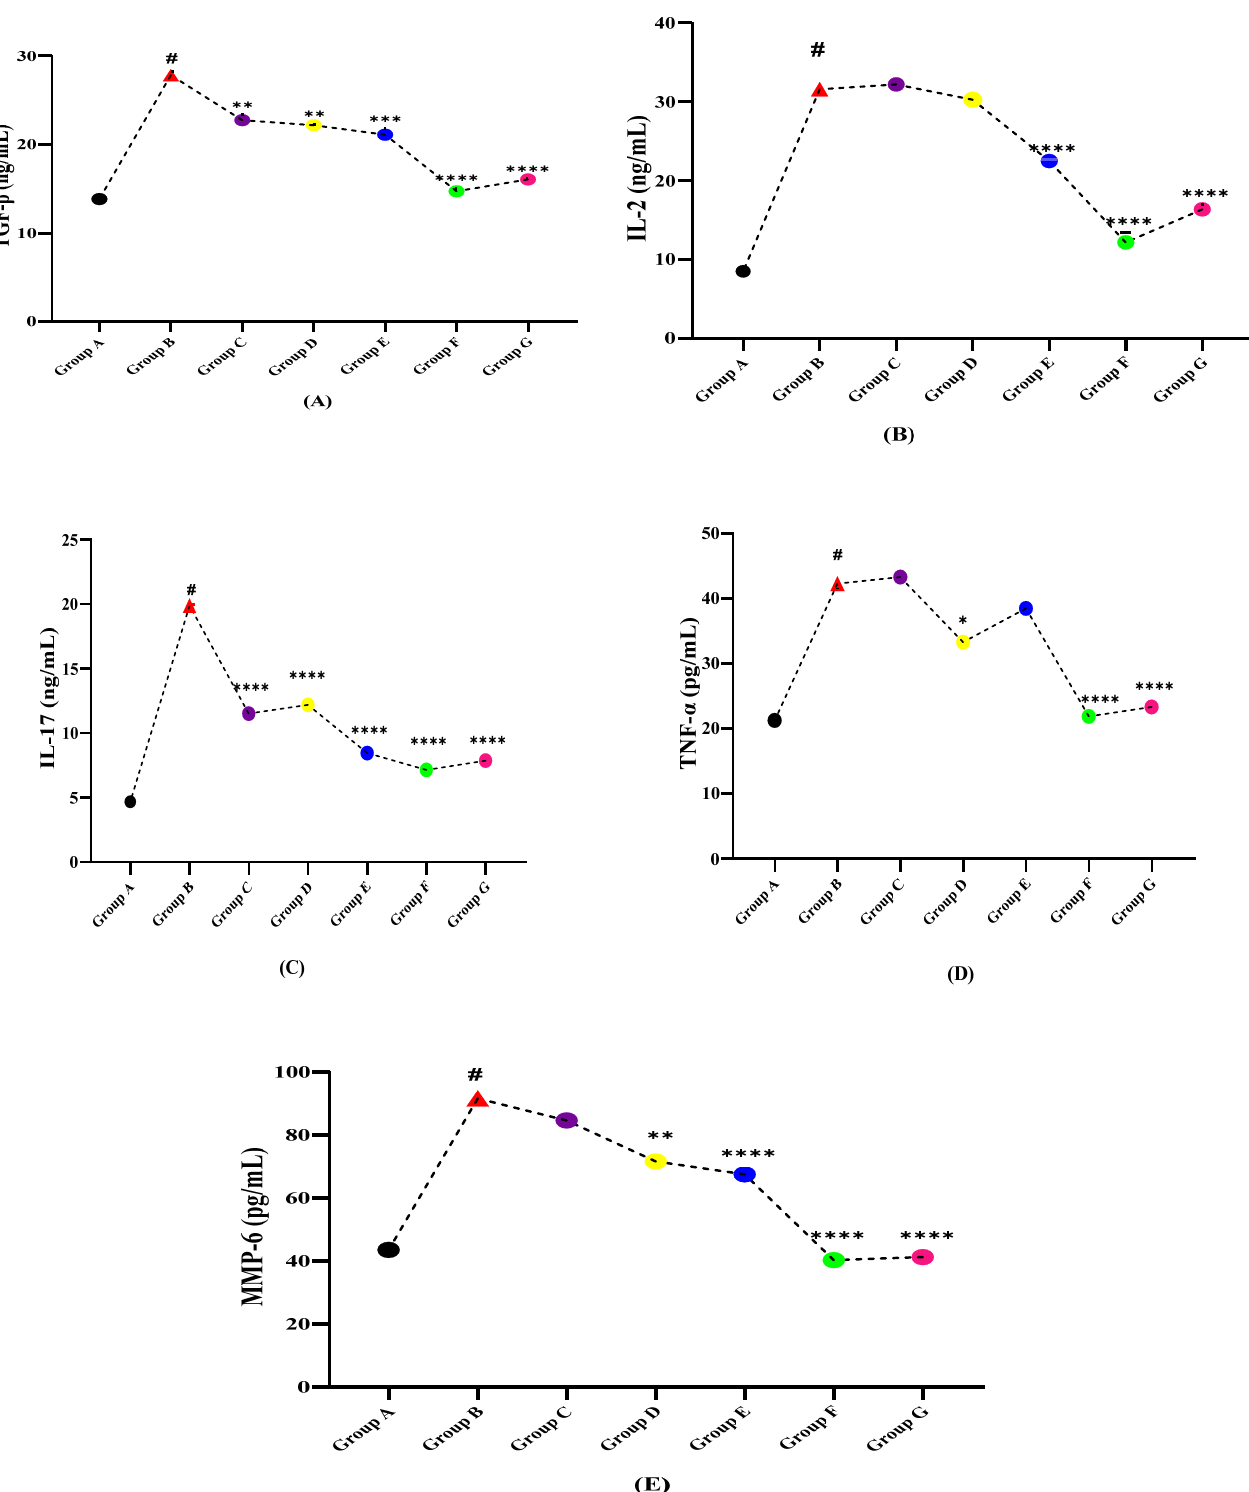
Figure 2. Effect of plant extracts treated groups against LPS induced multiple sclerotic Wistar rats ( A ) TGF- β , ( B ) IL-2, ( C ) IL-17, ( D ) TNF- α , and ( E ) MMP-6. ( # indicate reference group EAE model while Asterisks are showing the significance in the improvement of results as compared to reference group B). (*) slight significance, (**) moderate significance, (***) high significance, (****) very highly/effective significance.